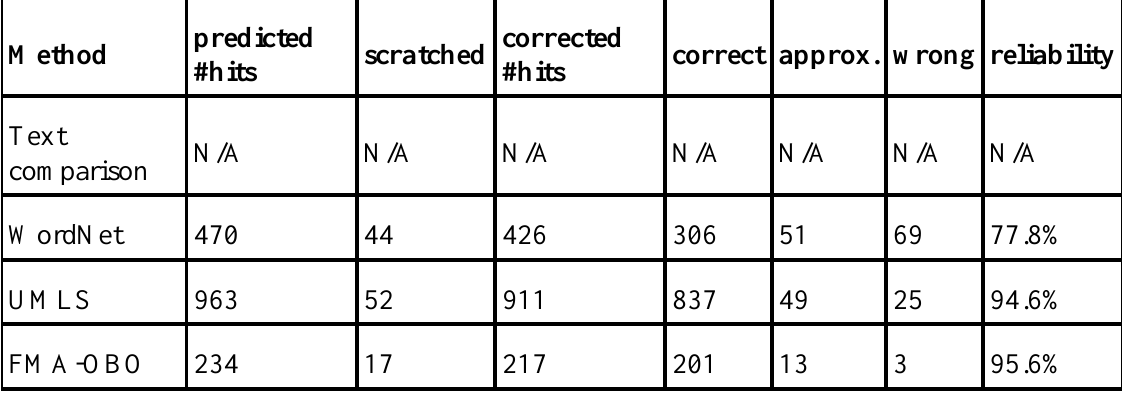
Table 4: Analysis of predicted first-order (i.e. parent-child) relations